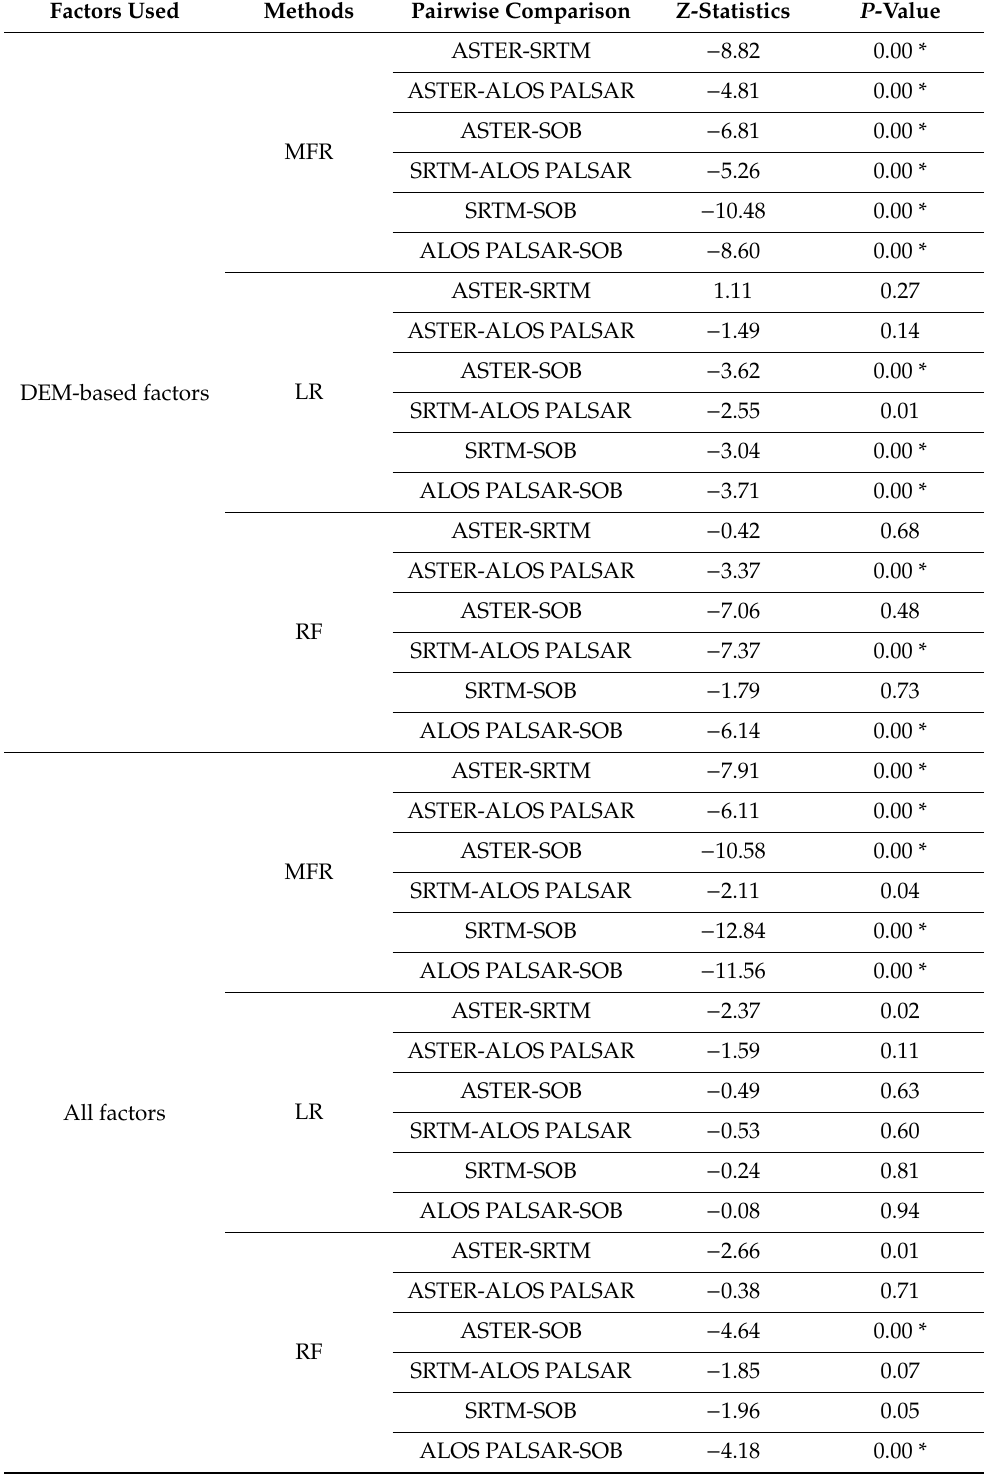
Table 5. Comparison of landslide susceptibility maps based on three di ff erent DEMs using Wilcoxon signed-rank